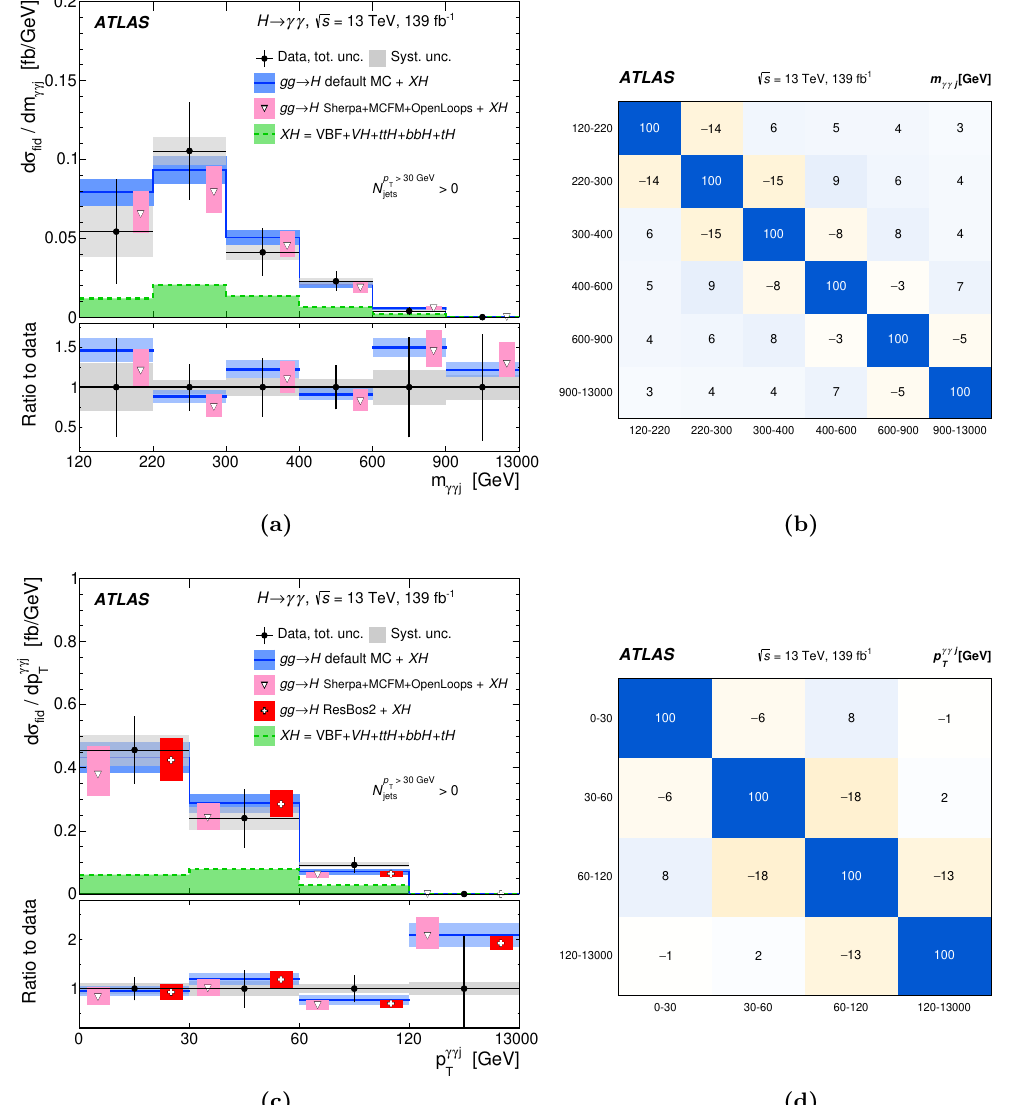
Figure 27. Particle-level fiducial differential cross-sections times branching ratio for the variables: (a) m and (c) p γγj together with the corresponding correlation matrices ((b) and γγj T